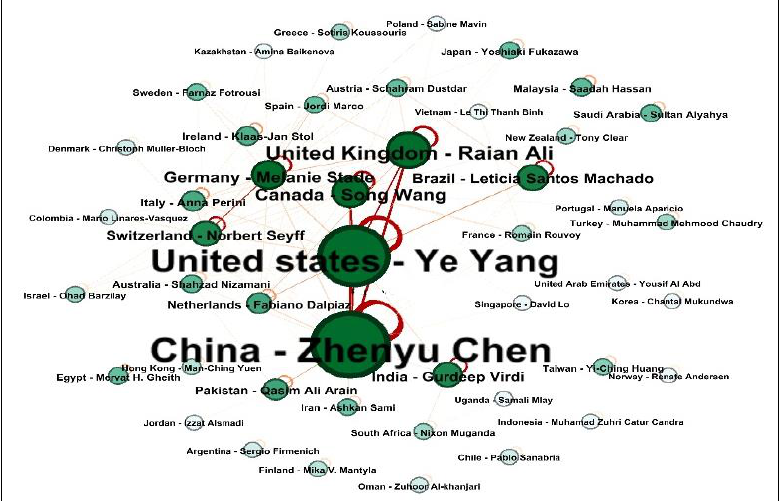
Figure 12. Most frequently cited co-authorship networks showing the top co-author in each country.